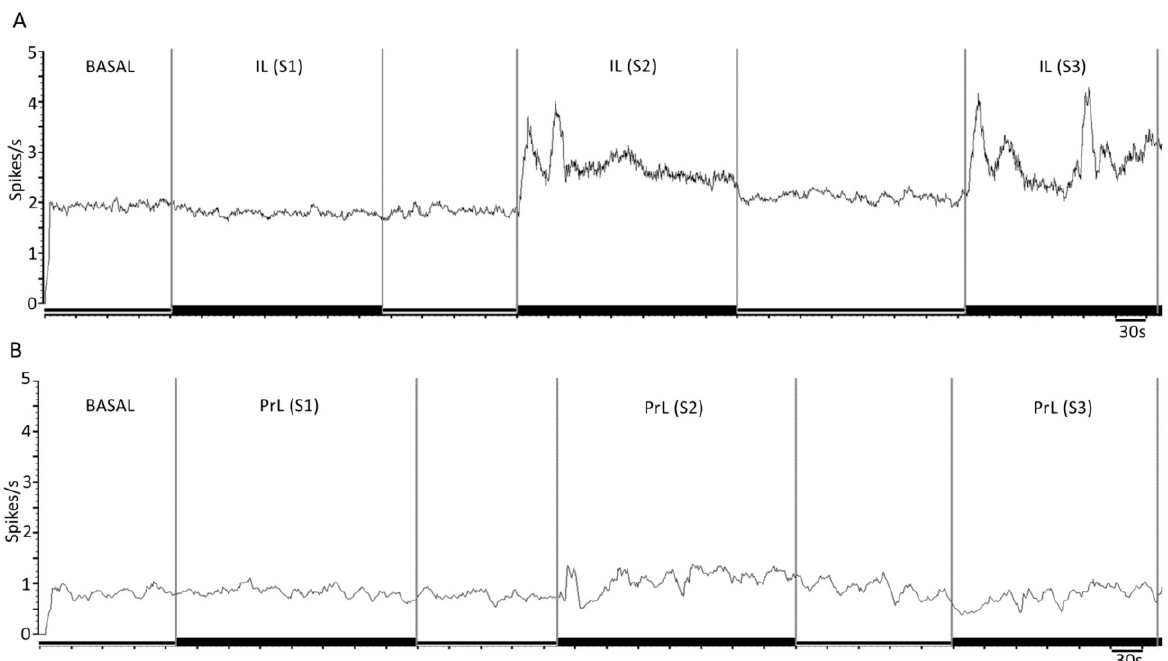
Figure 3. Representative example of the effect of electrical stimulation at increasing frequencies of infralimbic (IL) and prelimbic (PrL) neurons on 5-HT neuronal discharge in dorsal raphe (DR). ( A , B ) Mean frequency graphs showing spikes/s of representative recordings of DR 5-HT neurons during IL ( A ) and PrL ( B ) electrical stimulation at increasing frequencies (S1: 0.9 Hz, 0.2 ms, 1.7 mA; S2: 10 Hz, 1 ms, 0.5 mA; S3: 20 Hz, 1 ms, 0.5 mA; at least 200 s for each stimulation, 120 s between each). Note that IL (but not PrL) stimulation modulated the neuronal discharge of the recorded neurons ( A ) (no change → increasing → increasing for S1 → S2 → S3, respectively).